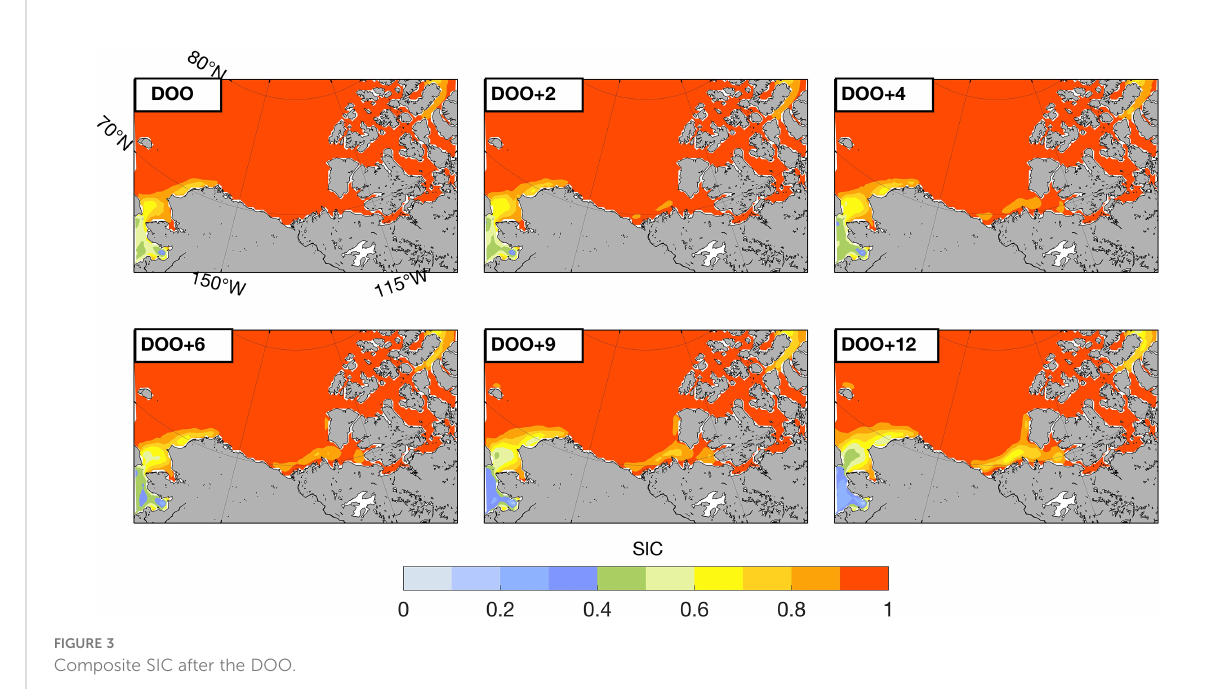
FIGURE 3 Composite SIC after the